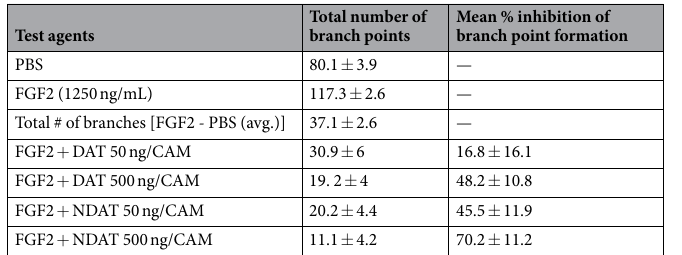
Table 2. DAT versus NDAT on fibroblast growth factor 2 (FGF2)-stimulated angiogenesis in the CAM. Data represent mean ± SEM, n =